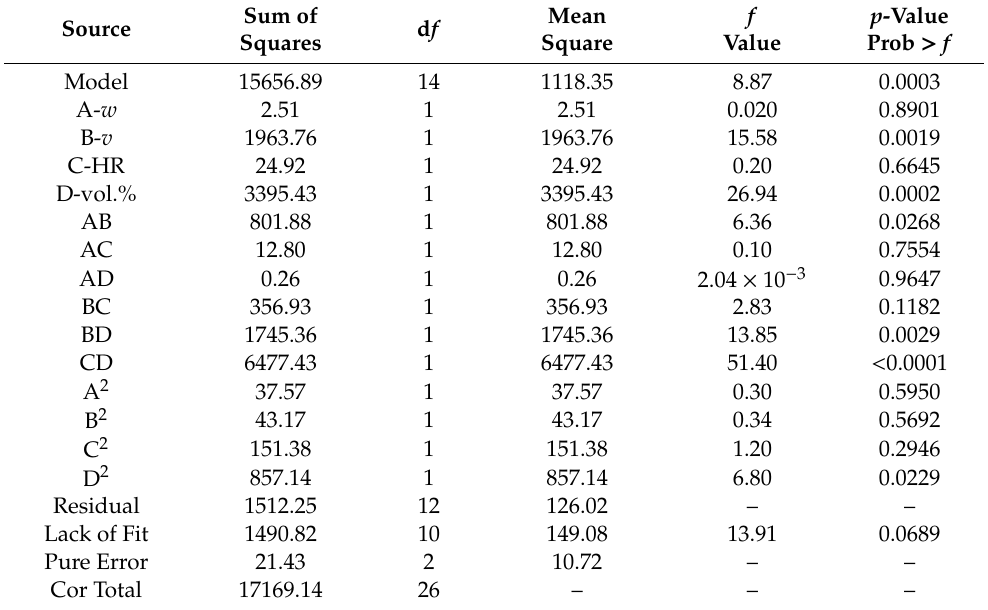
Table A2. The ANOVA model validation for Microhardness